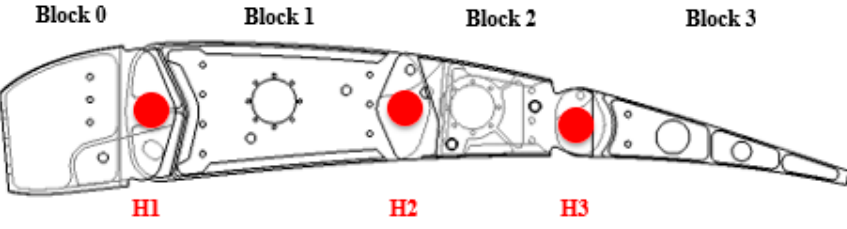
Figure 11. Morphing ring and hinges stations.